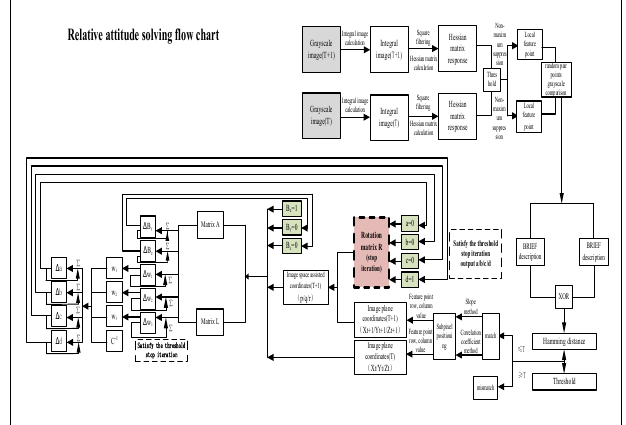
Figure 4. Relative attitude calculation flow chart